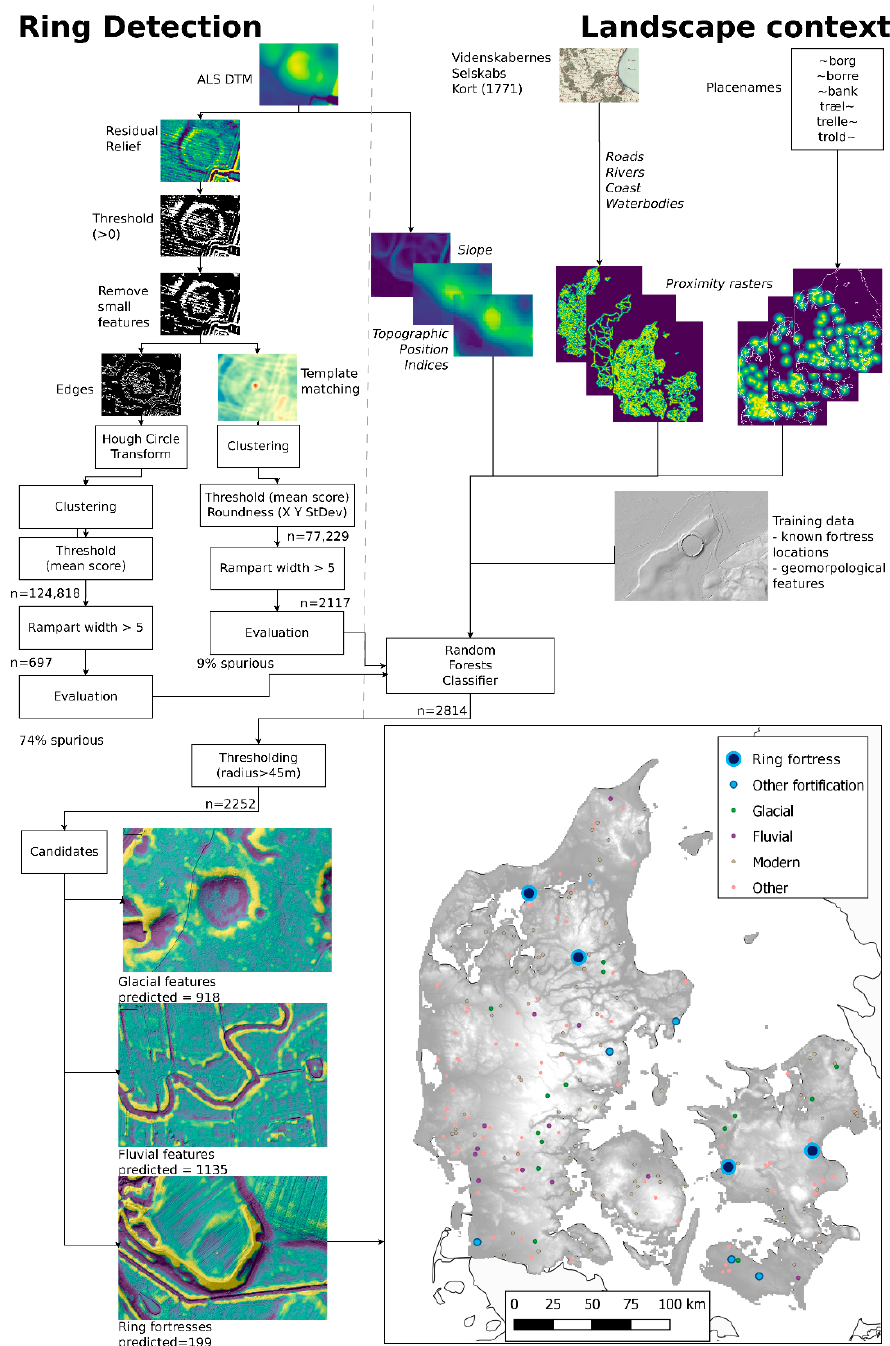
Figure 2. Summary of feature detection, classification, and evaluation workflow, with inset map of Denmark showing the locations of the resulting 199 ring features classified as candidate fortresses and their actual classifications.